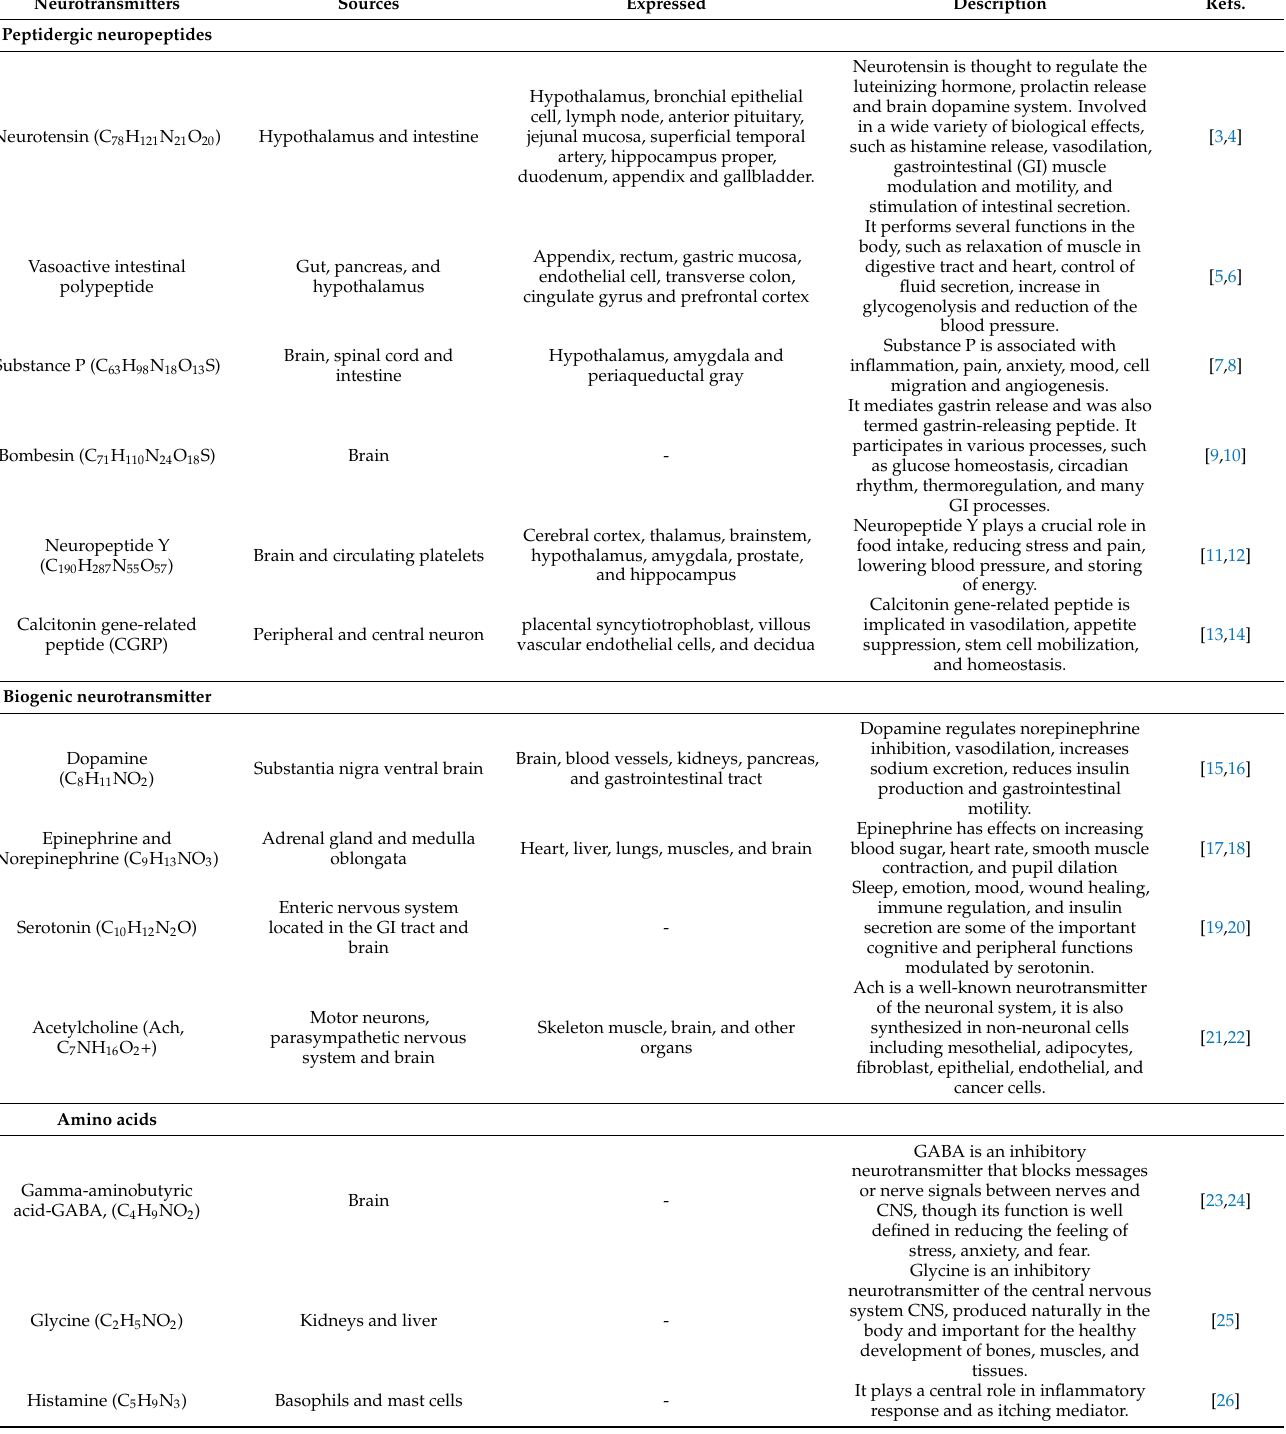
Table 1. List of neurotransmitters with corresponding sources, expression, and their brief